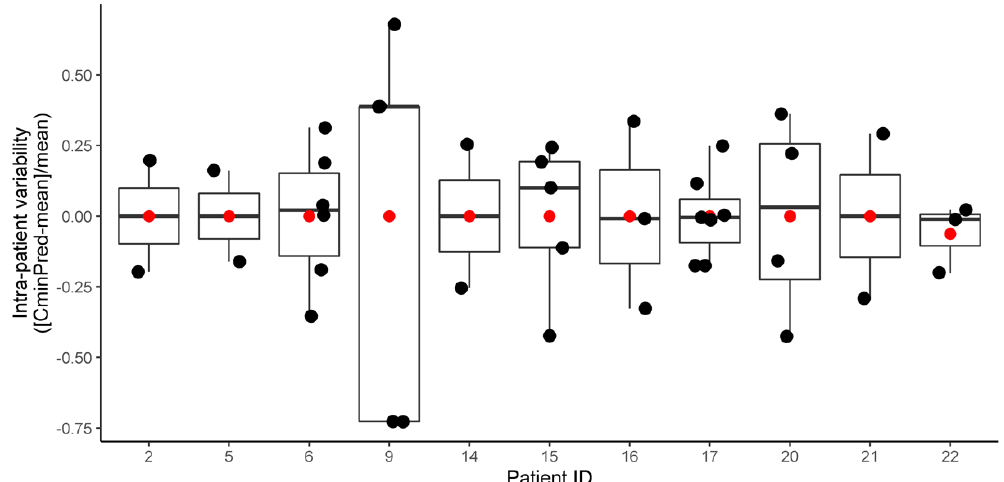
Figure A1. Intra-individual variability in olaparib C minPred calculated as % deviation of each individual C minPred from the mean concentration over the treatment period for the same individual (N = 11 patients with more than one olaparib exposure assessment and treated at standard dose).